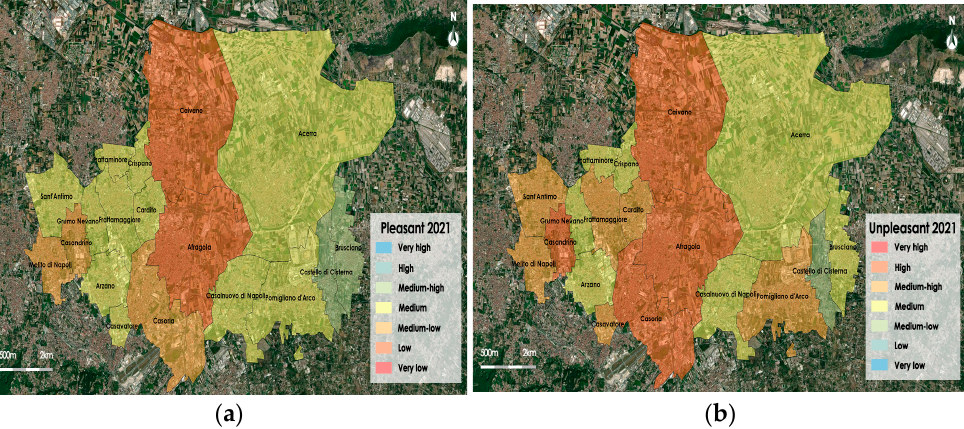
Figure 7. Pleasant and unpleasant emotion relevance thematic maps in the year 2021. ( a ) Pleasant emotion relevance. ( b ) Unpleasant emotion relevance. Table 4. Relevance of pleasant emotional categories in the year